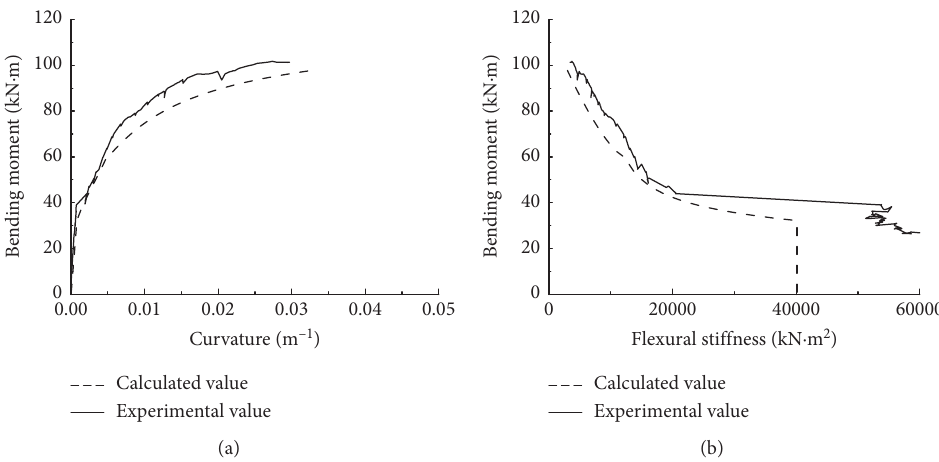
Figure 18: Beam B-1-40-4. (a) Bending moment-curvature curve. (b) Bending moment-stiffness curve.